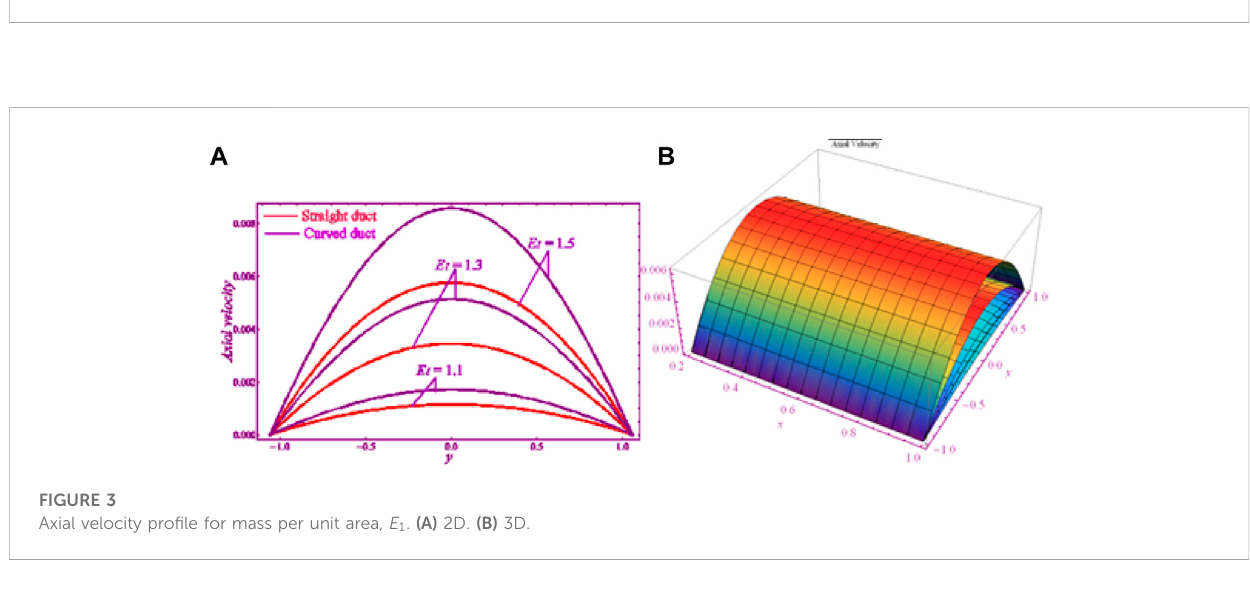
a is the wave height function which directly relates to the angular coordinate ″ z ″ . Figures 6 – 9 have been designed to visualize the variation in velocity curvature domain. These fi gures show the impact of α , E 1 , E 2 , and ϕ on the pro fi le of velocity w , respectively,